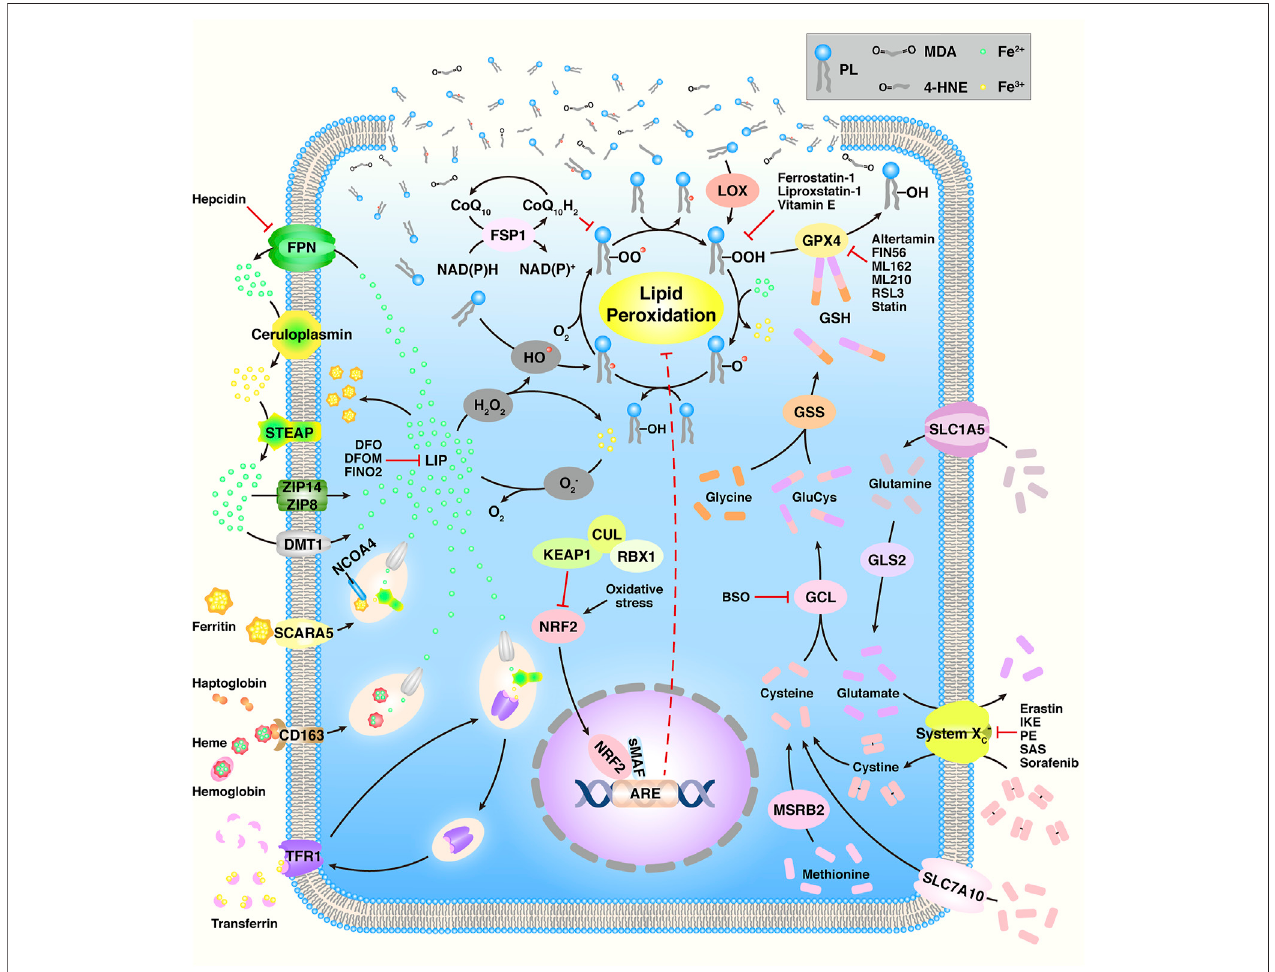
FIGURE 1 | Overview of the ferroptosis mechanism. Adapted from Shi et al., (2021) Copyright @ 2021 (Frontiers).